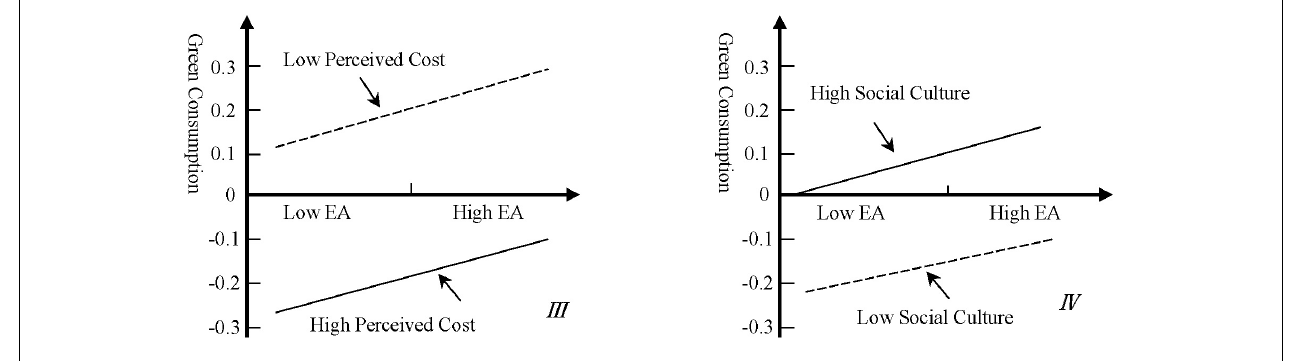
FIGURE 3 | The moderating effect of perceived cost and social